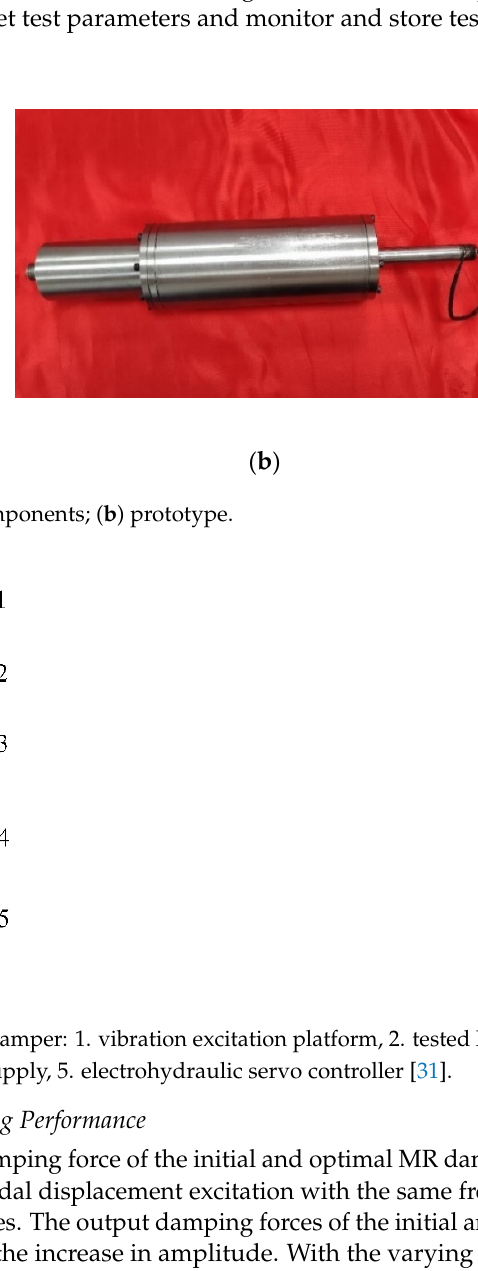
( b ) Figure 16. Damping force under different amplitudes: ( a ) initial; ( b ) optimal. The damping characteristics of the initial and optimal MR damper were discussed by fixing the input current and amplitude, but with varying frequency. Figures 17 and 18 show the output damping force of both the initial and optimal MR dampers at the input excitation current of 1 A, and the amplitude of 7.5 mm and 10 mm, respectively. The output damping forces of both dampers increase slowly with the increase in the exciting frequency. When the amplitude is 10 mm and the frequency is 1 Hz, the exciting speed is 0.0628 m/s, the maximum output damping force of the initial MR damper with the bended magnetic circuit and folded flow gap is 4739 N, and the maximum output damping force of the optimal damper is 6845 N.